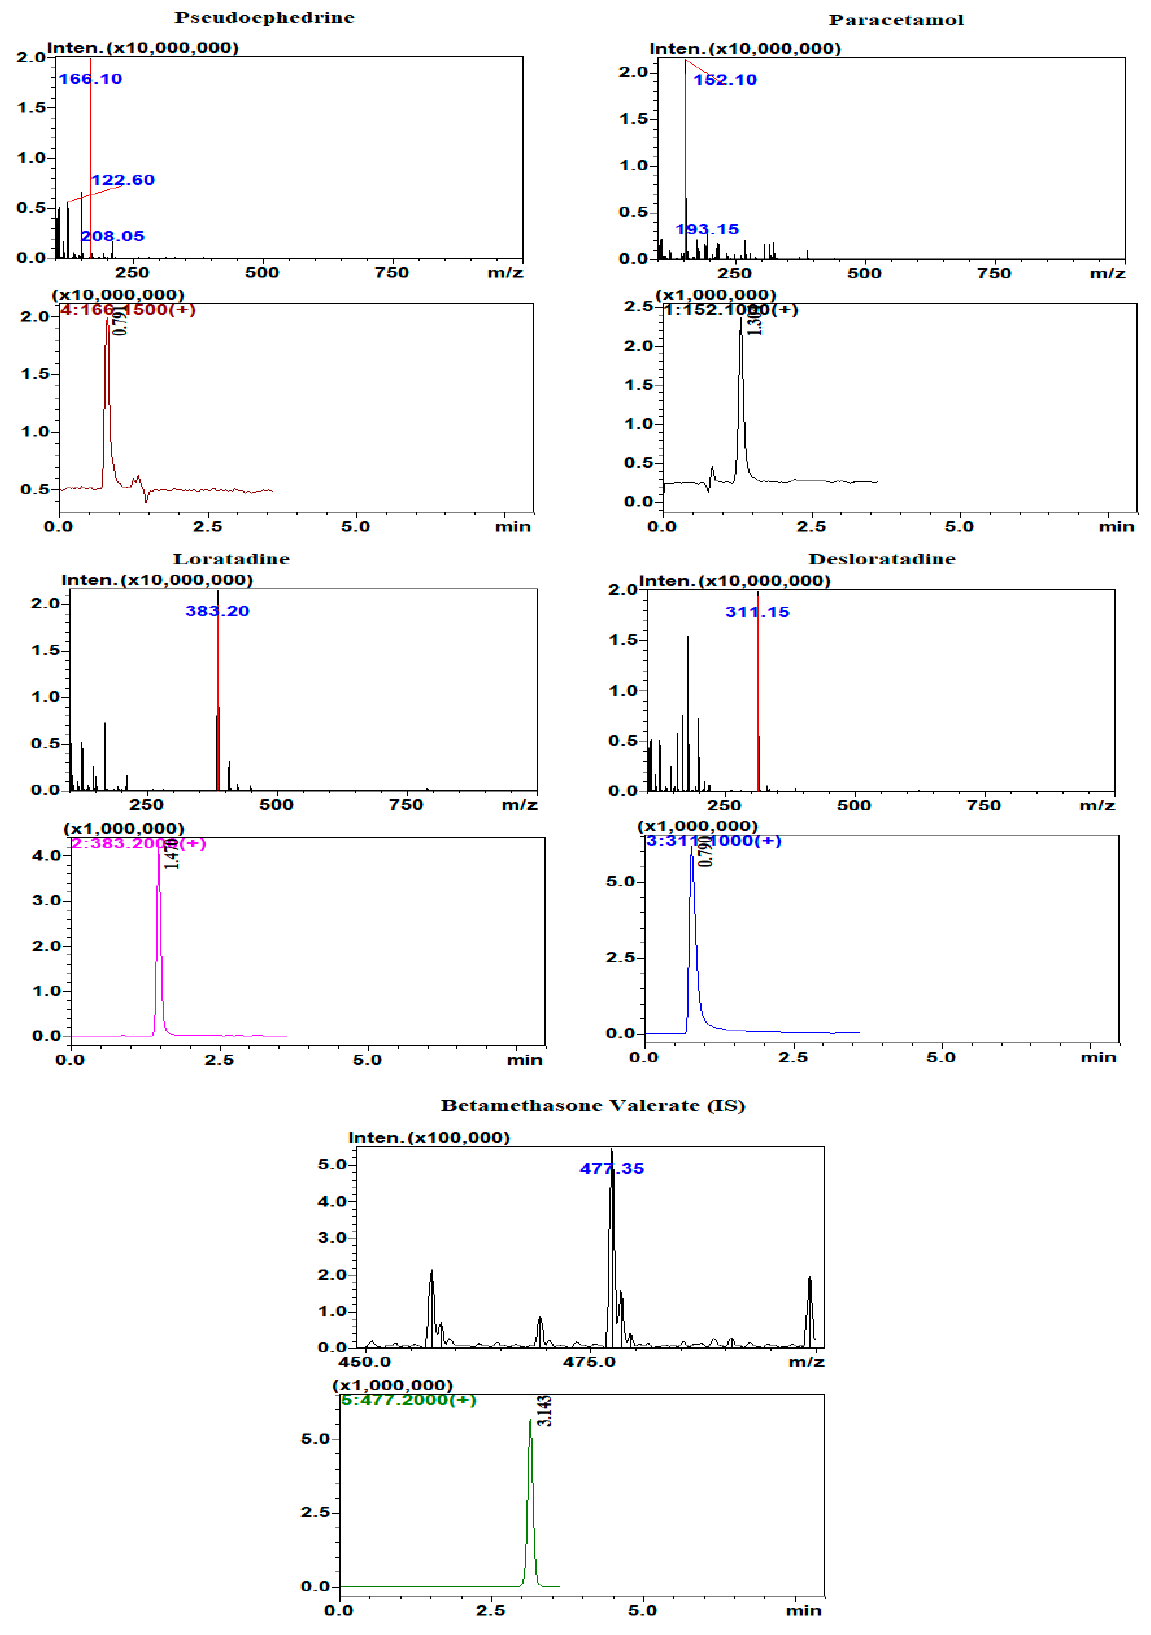
Figure 5. Full MS scan ( top ) and SIM chromatograms ( bottom ) of each of the analyzed drugs.